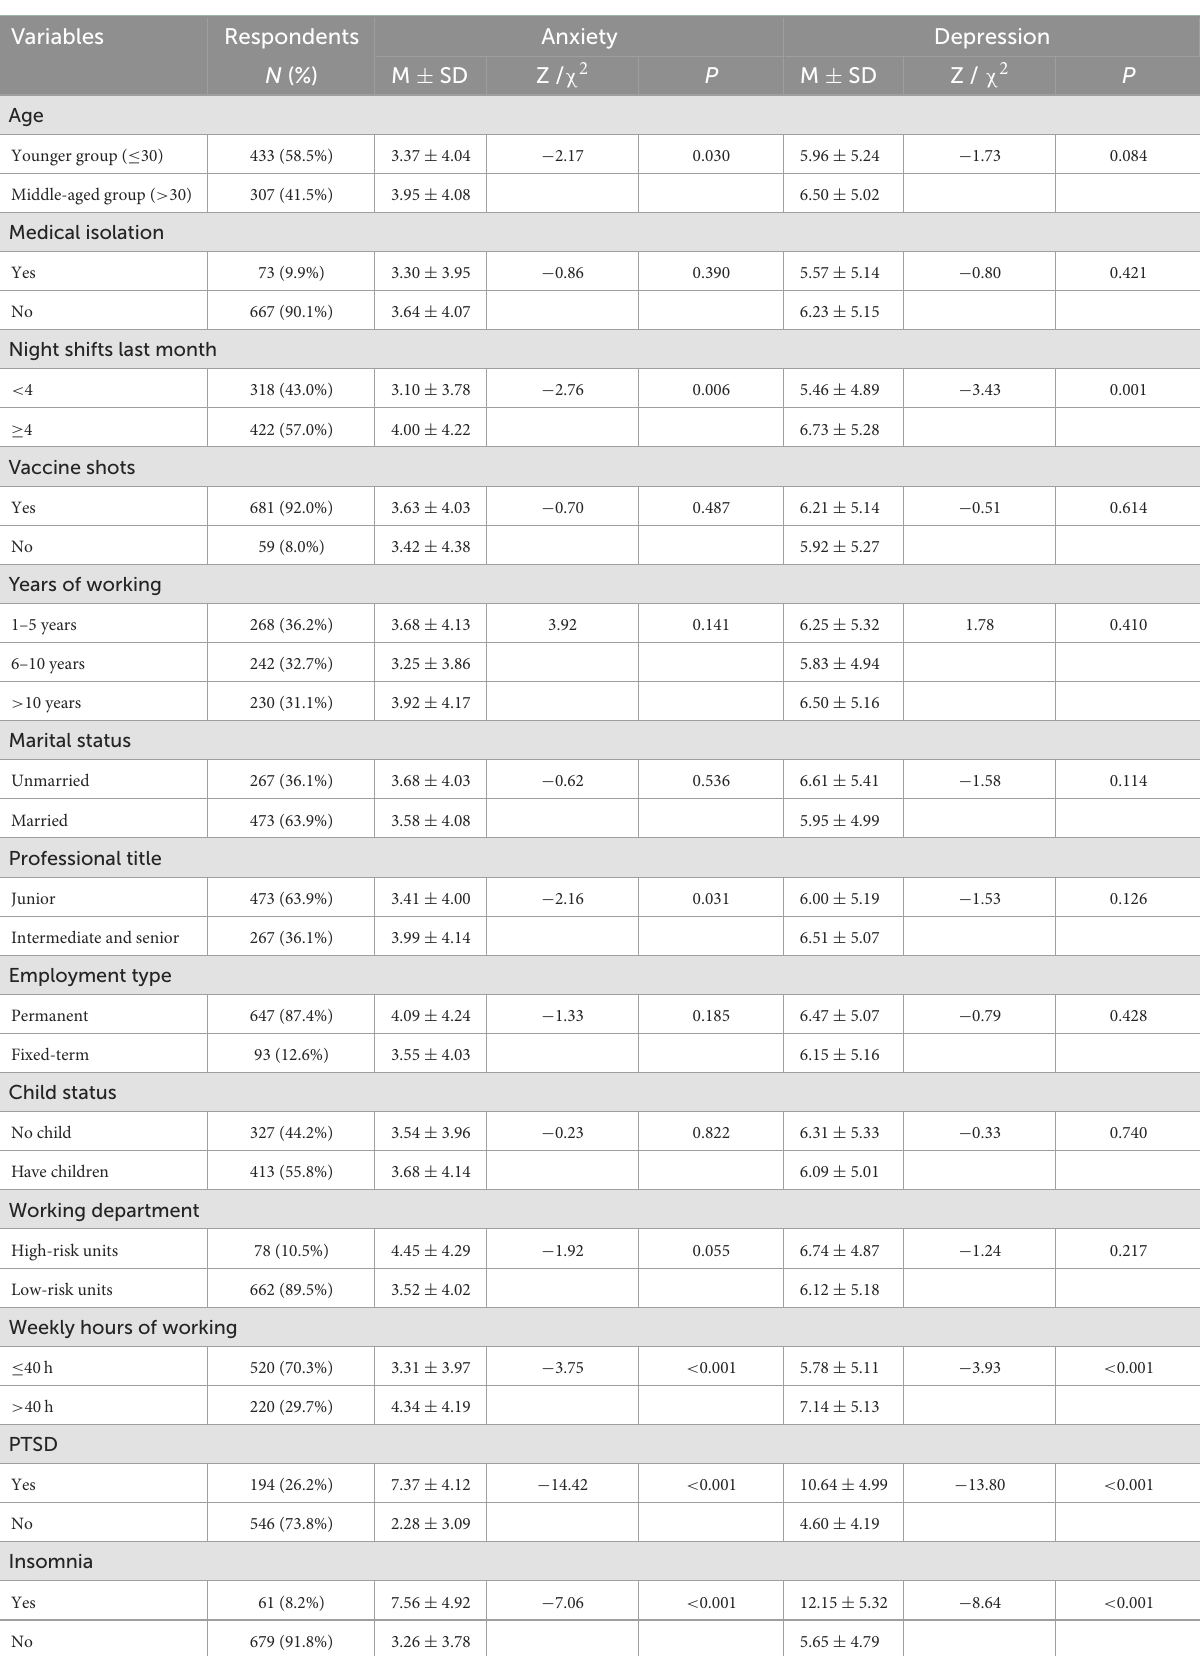
TABLE 1 Characterization and distribution of anxiety and depression.